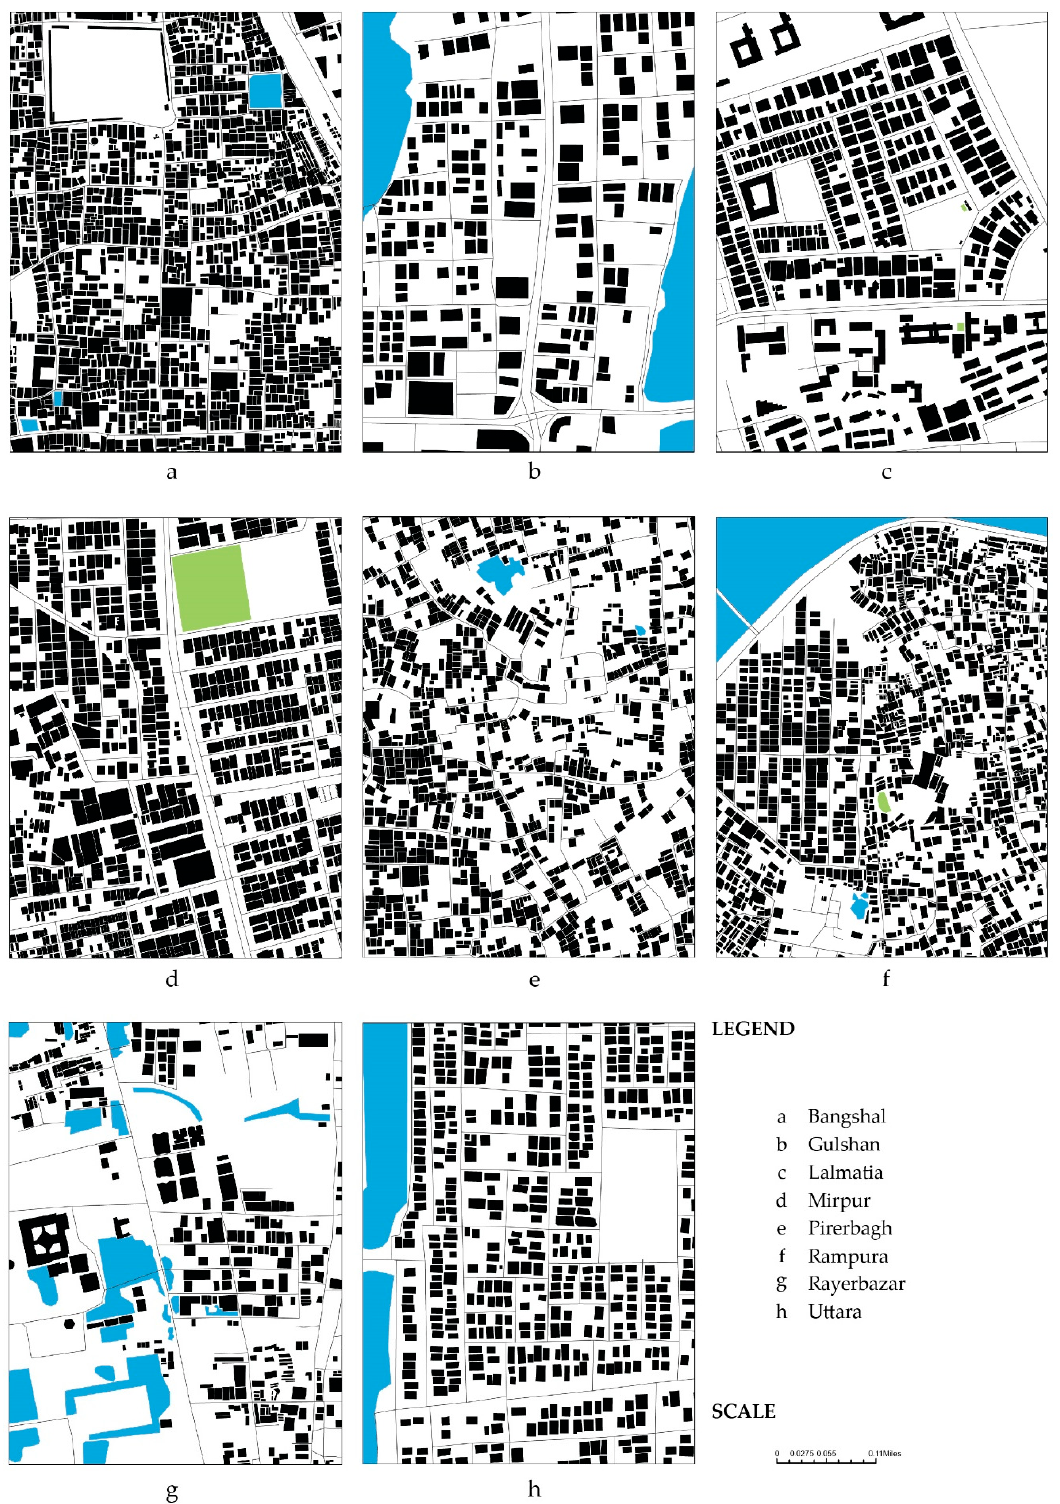
Figure 6. Ground space intensity and spatial pattern of eight selected areas in Dhaka.